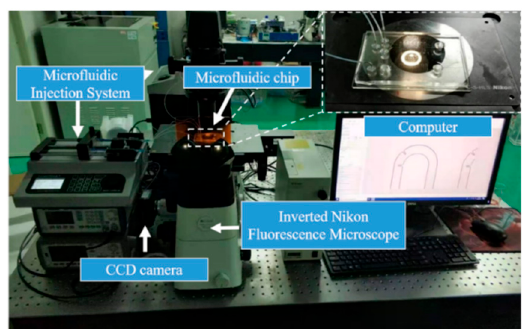
Figure 5. Integrated experimental platform for exosomes isolation.